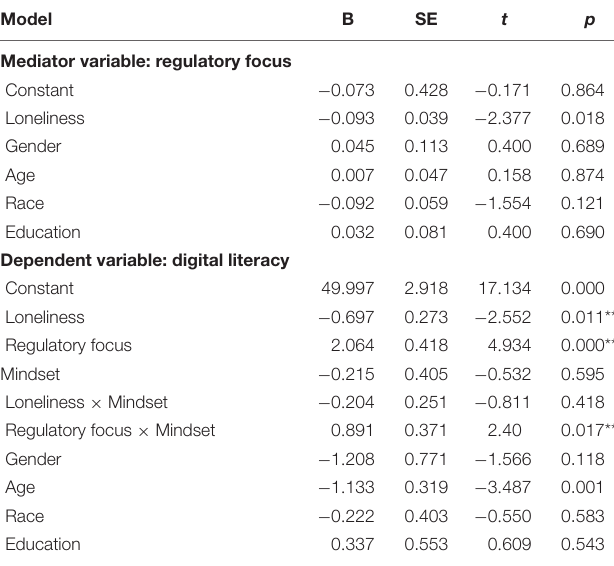
TABLE 2 | Moderated mediation analysis.